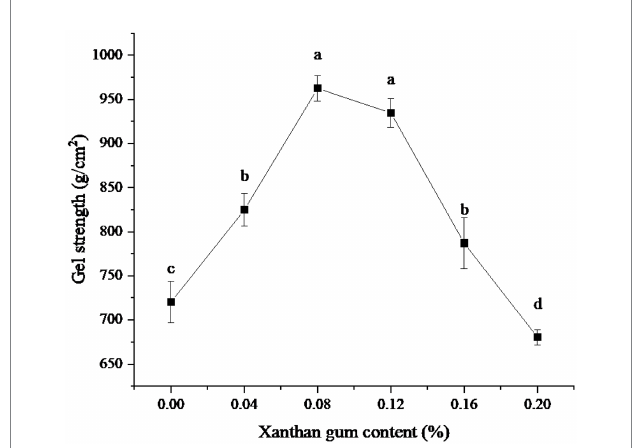
FIGURE 1 Effect of xanthan gum content on gel strength of protein powder. Different lowercase letters express the significant differences ( p <